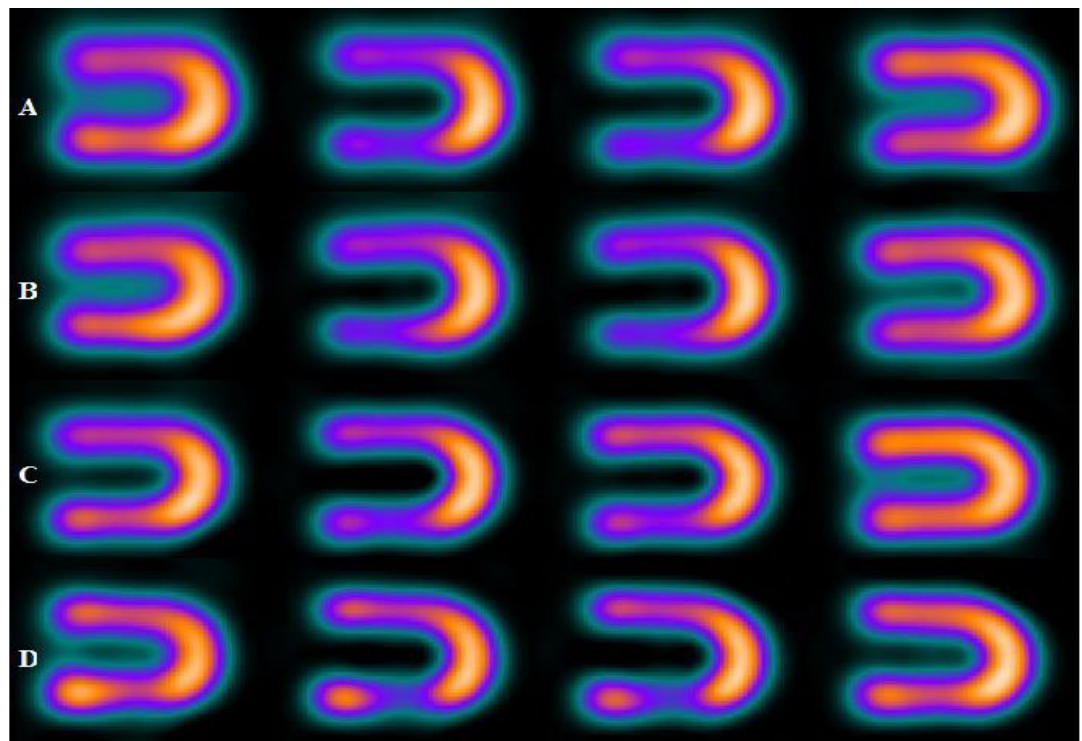
Figure 4. Defect in interior and inferior region of myocardial SPECT image using 20% energy window at four positions, where the rows (A, B, C, and D) at (the center, 5 cm, 10 cm, and 15 cm), respectively.